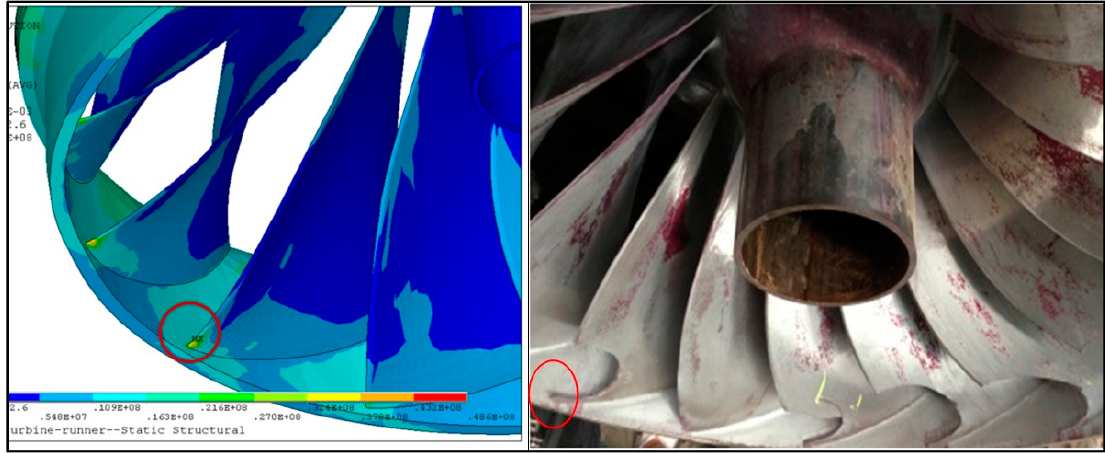
Figure 9. Maximum stress spot at the joint blade-band and initiation of the real fracture.